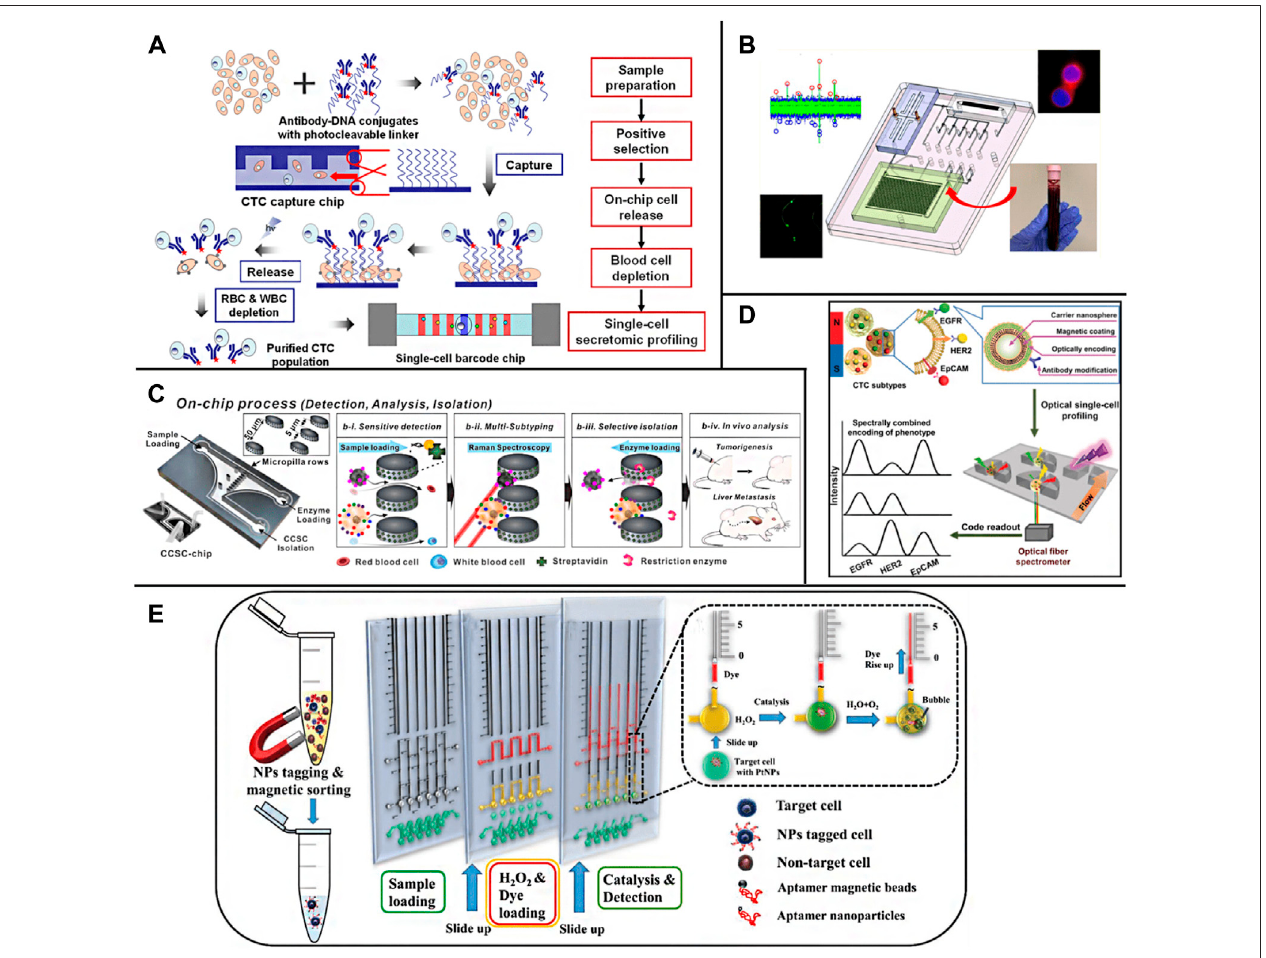
FIGURE7| On-chipdetectionofCTCs (A) OverallstrategyforCTCisolationandsingle-cellsecretomeanalysis(Dengetal.,2014); (B) Asystemmodularitychipfor the analysis of rare targets (SMART-Chip) (Pahattuge et al., 2021); (C) A 3-step process for blood sample solutions with RANs labeled CCSCs and CTCs (Cho et al., 2018); (D) A multifunctional nanosphere-mediated micro fl uidic platform for multiplex biomarker pro fi ling of heterogeneous CTCs (Wu et al., 2020); (E) The working principle of the aptamer-conjugated PtNPs with volumetric bar-chart chip readout for quanti fi able visual detection of CTCs (Abate et al., 2019) .